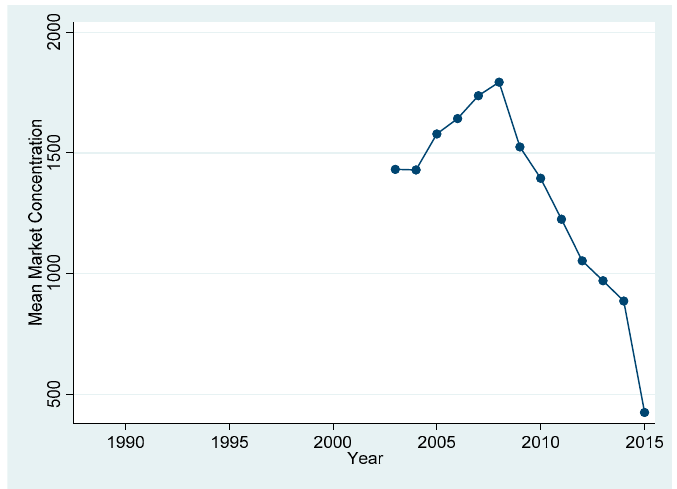
Figure 1. Mean market concentration of Chinese banks over the years until 2015.